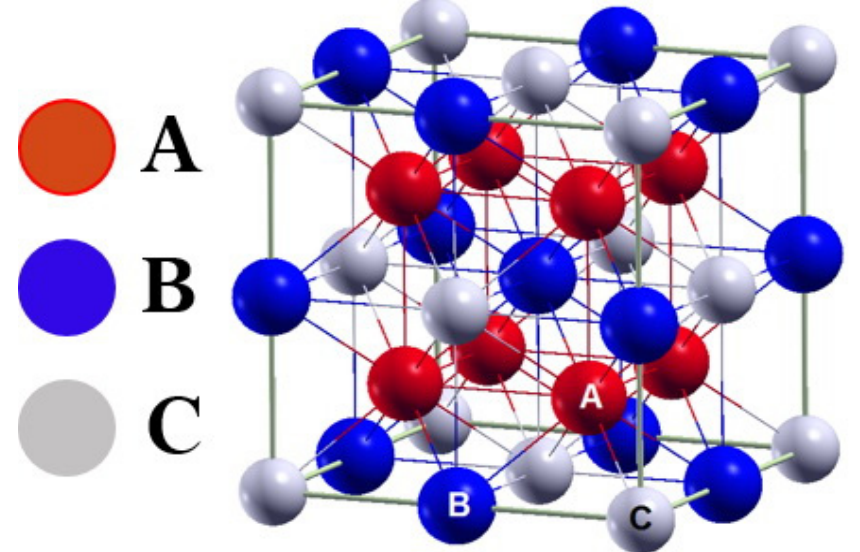
Figure 1. Full Heusler alloy structure model [19].